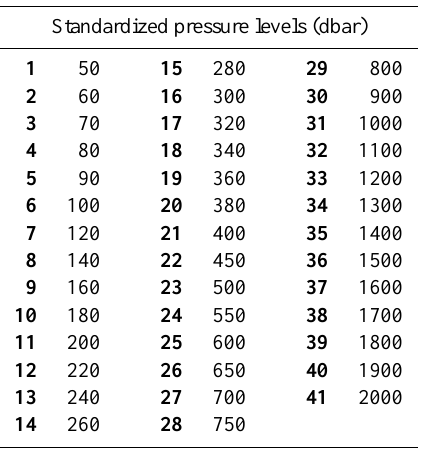
Table 1. Standardized pressure levels (dbar) to which all profiles are linearly